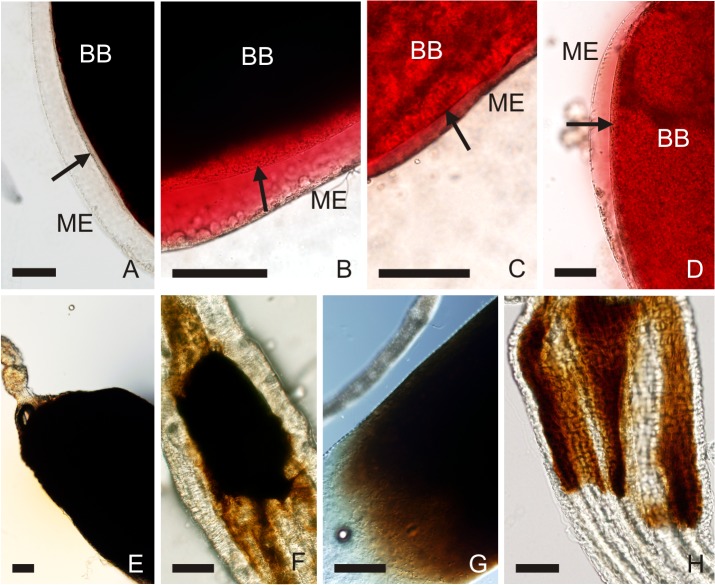
Formation (A-D) and degradation (E-H) of the peritrophic matrix (PM) in various sand fly species.The thin PM separating the blood bolus (BB) from the midgut epithelium (ME) is indicated by the arrow. It appears first by 1h PBM in S. schwetzi (4A) and P. papatasi (4B), 6 h PBM in P. orientalis (4C) and 12h PBM in P. argentipes (4D). At the end of digestion, the bloodmeal remnants are still enclosed by intact PM in S. schwetzi on day 3 PBM (4E). In contrast, in the other species studied bloodmeal remnants leak to abdominal midgut through broken PM, in P. papatasi typically by day 4 PBM (4F), in P. orientalis by day 3 PBM (4G) and in P. argentipes by day 2 PBM (4H). Scale bar = 50 μm.